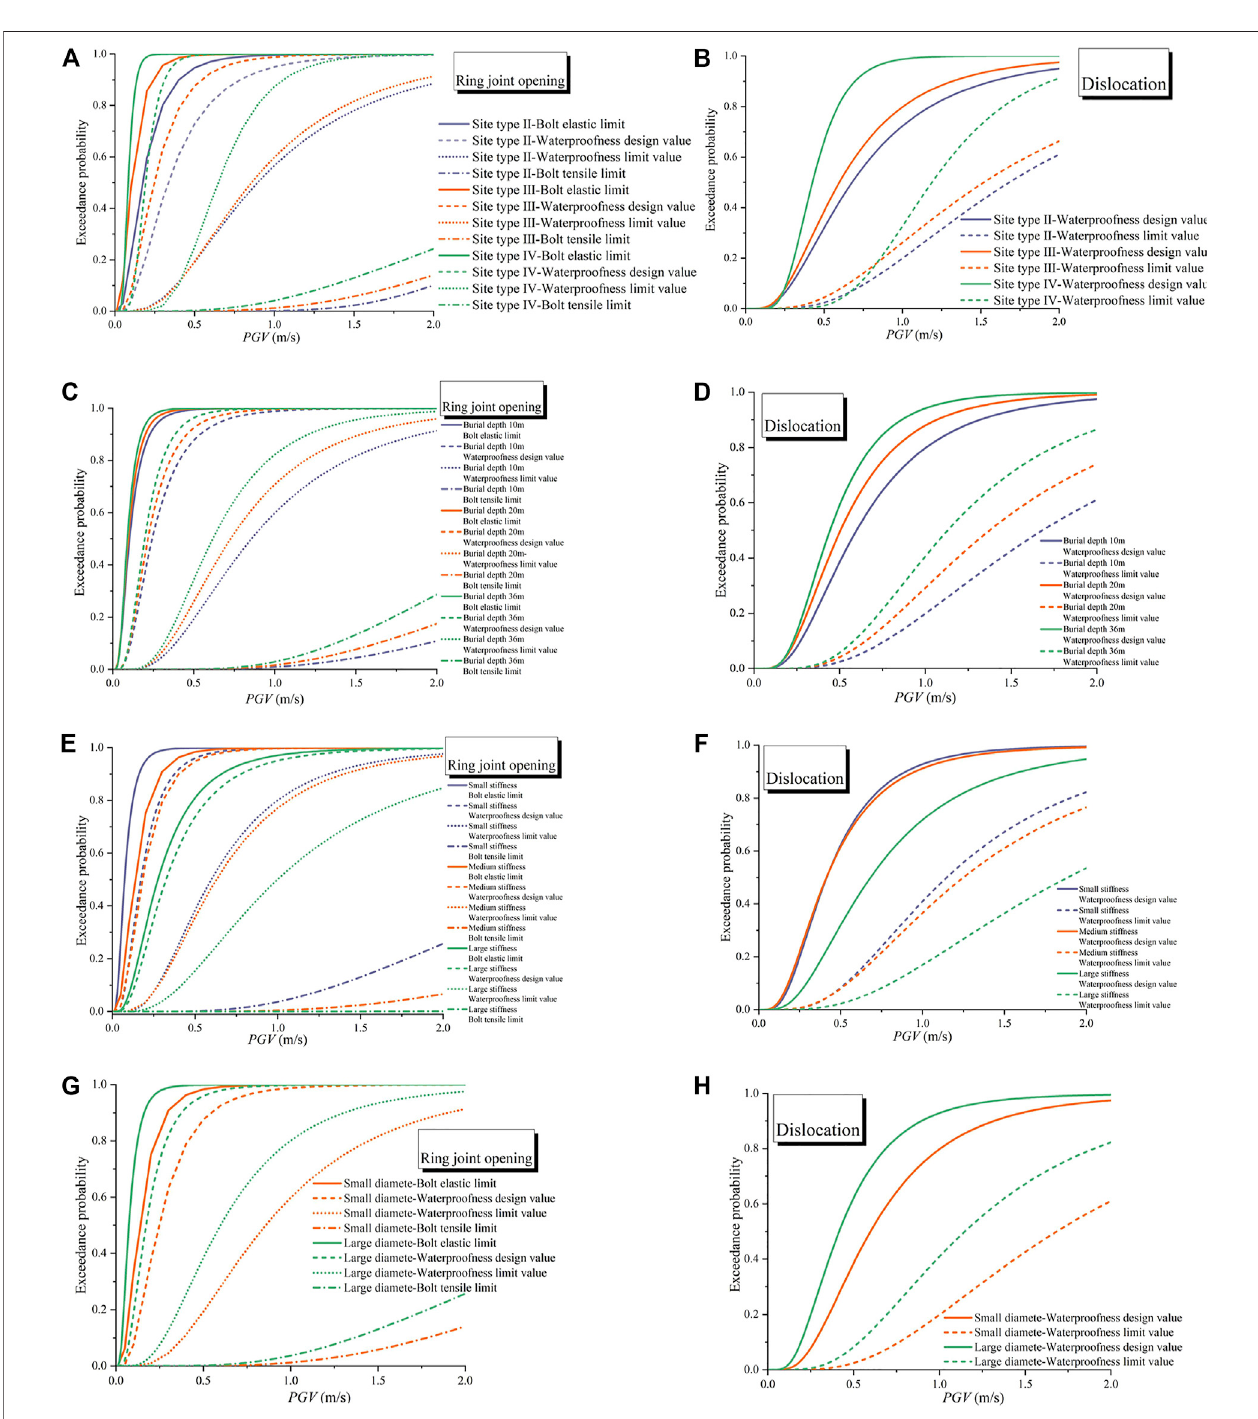
FIGURE 10 | The seismic fragility curves of the shield tunnel in the various site types (A,B) , the various depths of burial of the tunnel (C,D) , various ring spring stiffnesses (E,F) and the various cross section sizes (G,H) .